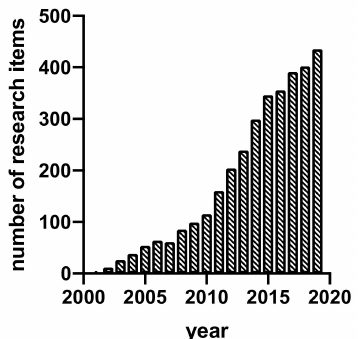
Figure 2. Research items per year with the words “decellularization” or “decellularized” in the title (Source: https: // scholar.google.es “allintitle: decellularized OR